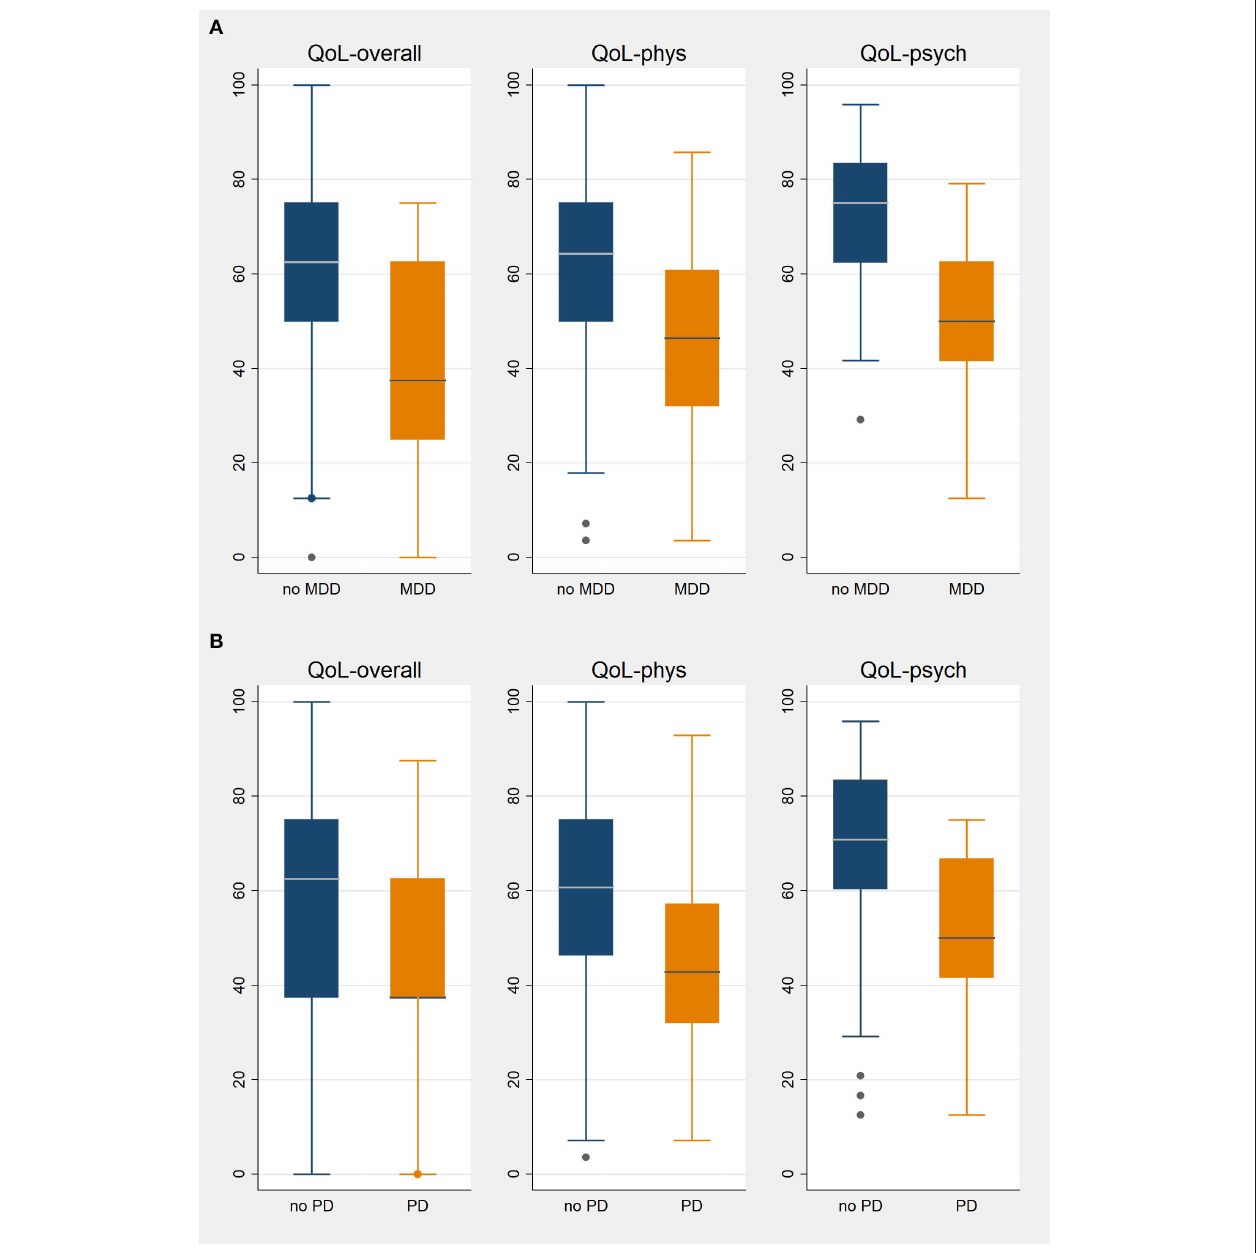
FIGURE 4 | Quality of life in PAH patients with or without major depression disorder (A) or panic disorder (B) . QoL, quality of life; phys, physical; psych, psychological; MDD, major depression disorder, PD, panic disorder; box plots show medians and interquartile ranges.